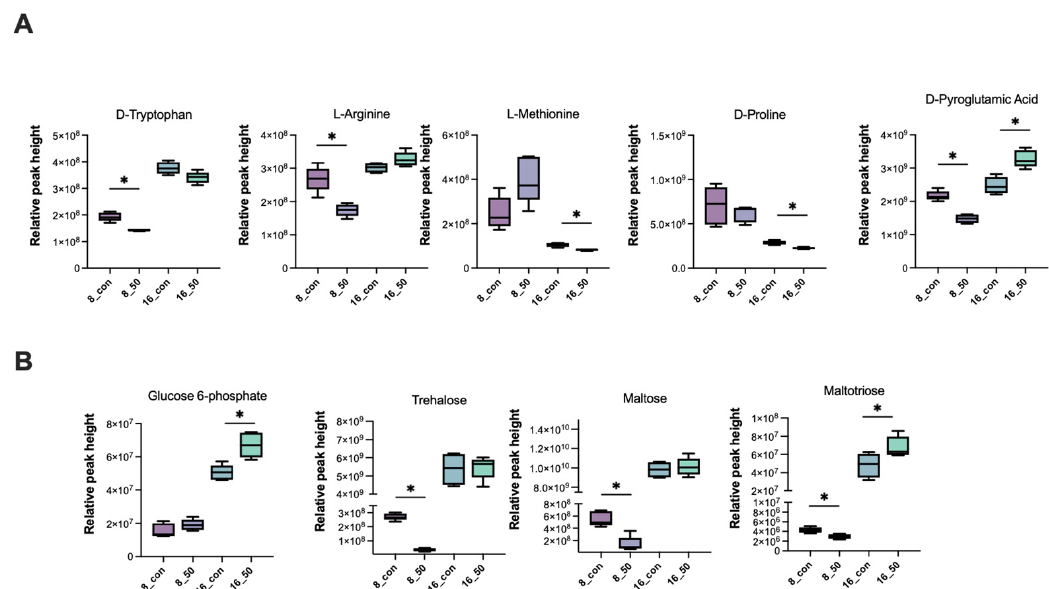
Figure 8. Changes in selected differential metabolites, including ( A ) amino acids and ( B ) carbohy- drates. (* p < 0.05 vs. control group)